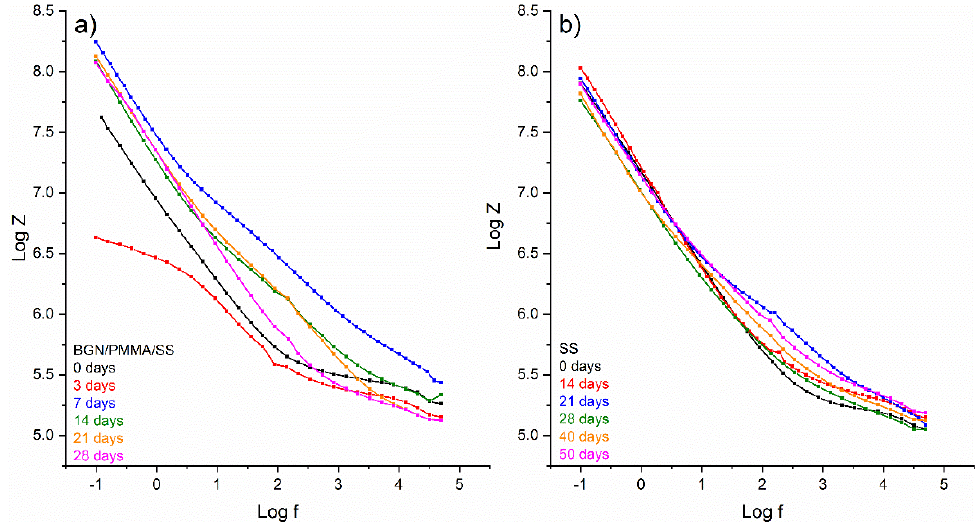
Figure 11. Impedance plots for BGN/PMMA/SS ( a ) and SS ( b ) samples after different immersion